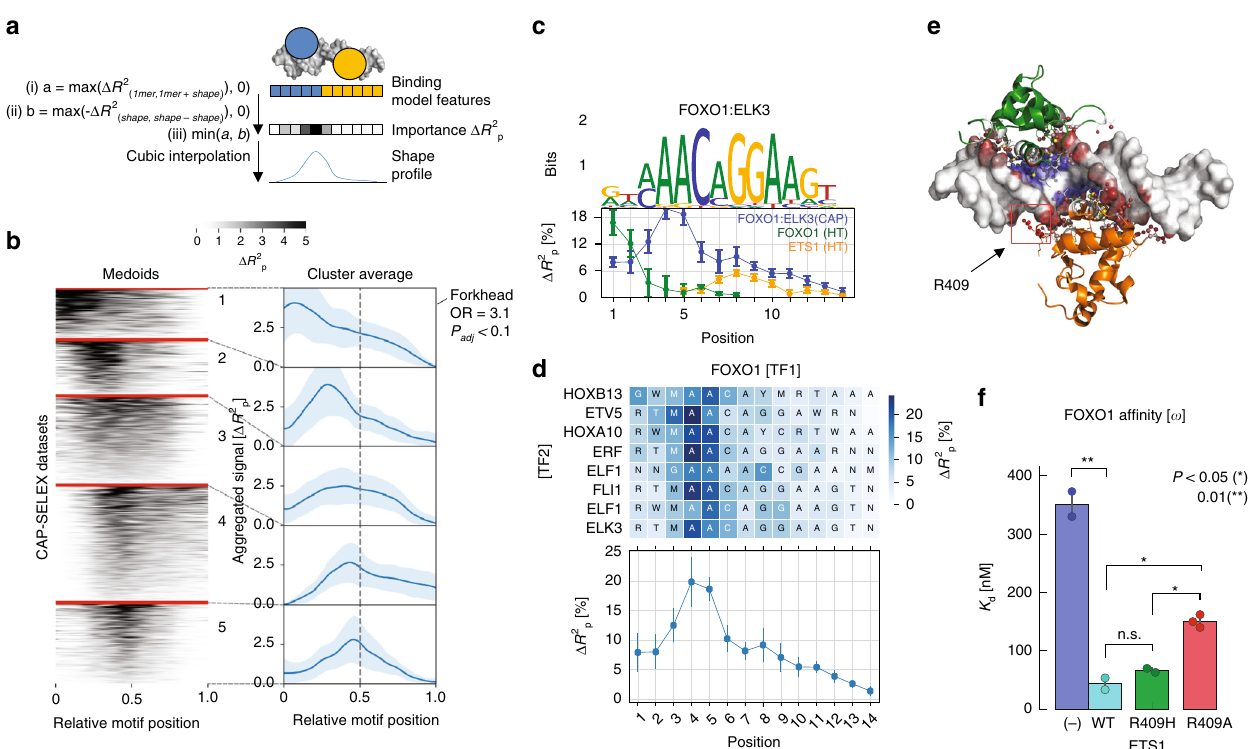
Fig. 3 Clustering of shape improvements by position in CAP-SELEX data reveal TF co-binding shape-recognition biases. a Scheme describing shape pro fi les calculation (top). For a homodimeric or heterodimeric protein-DNA complex, shape features are individually added to assess their relative contribution to the global increase in performance. Averaged contributions are transformed by interpolation to a curve representation. (Methods) b PAM clustering of shape pro fi les across all CAP-SELEX models analyzed (left). Each row shows a composite motif ( N = 438). Five representative clusters are separated by red lines. Average shape pro fi les for each cluster. Blue shades indicate one standard deviation (right). Enrichments for Forkhead TFs within cluster 1 is labeled (OR = odds ratio). c Forkhead-Ets FOXO1:ELK3 motif (top), Δ R 2 p changes (as percentages) in FOXO1:ELK3 CAP-SELEX data (bottom) (blue line). Additional lines indicate equivalent values for FOXO1, and ETS1, an ELK3 paralogue (green and orange, respectively) calculated from HT-SELEX data 9 . Error bars indicate windowed average standard deviation, with window value of 4. d Δ R 2 p per position changes are shown for selected CAP-SELEX data that contain FOXO1 in combination with other binding partners of similar binding topology (top). IUPAC DNA symbols in heatmap indicate aligned k - mers. Column averages for heatmap values. Error bars indicate standard deviations in each position (bottom). e FOXO1-ETS1 ternary complex. ETS1 residue R409 interacting with DNA minor groove is highlighted in a red box (PDB ID: 4LG0). Visualization was enhanced using PDIViz 63 . f Dissociation constant measurements using ITC for FOXO1 binding to ω DNA sequence upon addition of ETS1 wild type and selected mutants (Asterisk (*) indicate adjusted p -values obtained using two sided t